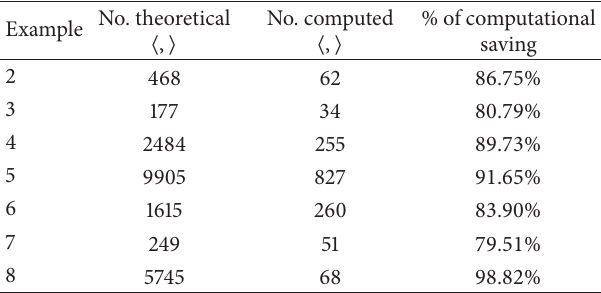
Table 1: Computational saving related to the involved inner prod- ucts ⟨, ⟩ in the examples presented in Section